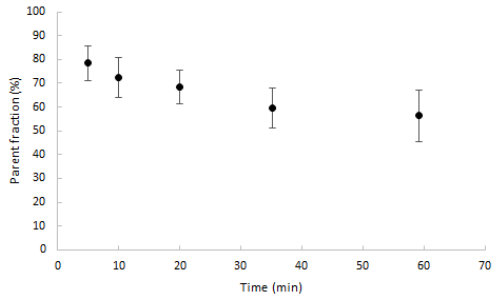
Figure 3. Average percentage of parent fractions in plasma (dots) with one SD range (error bars) as function of time